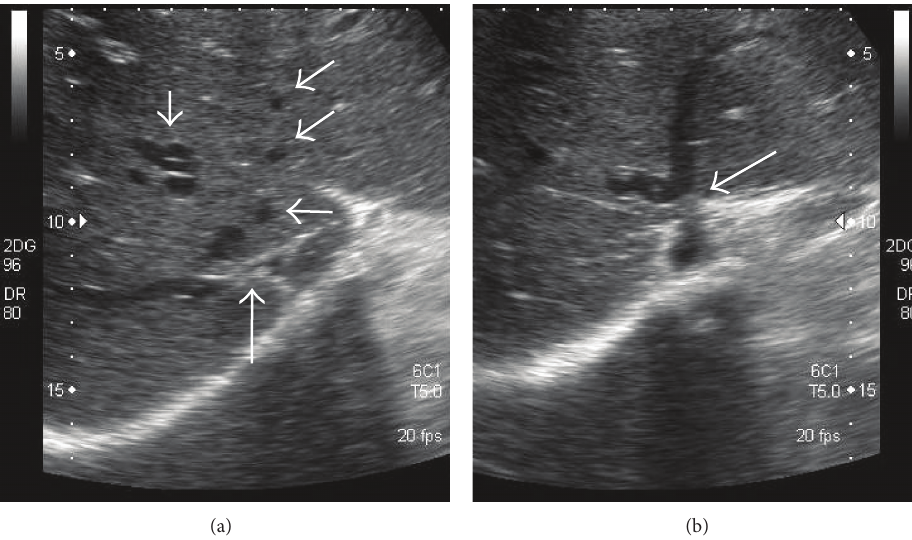
Figure 12: Gray-scale US image demonstrating stenosis at the ostium of right hepatic vein (long white arrow in (a)) and the common channel of middle and left hepatic vein (arrow in (b)) with multiple intrahepatic collaterals (small white arrows in (a)).